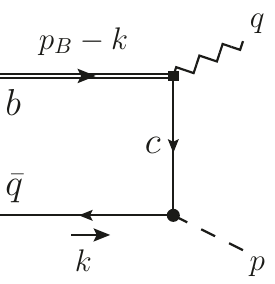
Figure 1 . Two-particle contribution to the correlation function Π µ ( n · p, ¯ n · p ) at tree